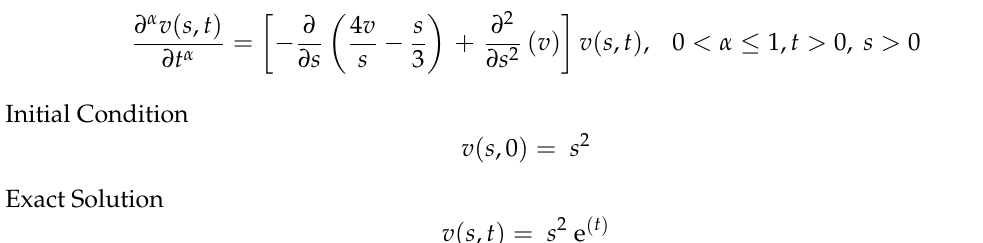
Figure 3:3D Solutions of example1 with di⁄erent values of (cid:11)